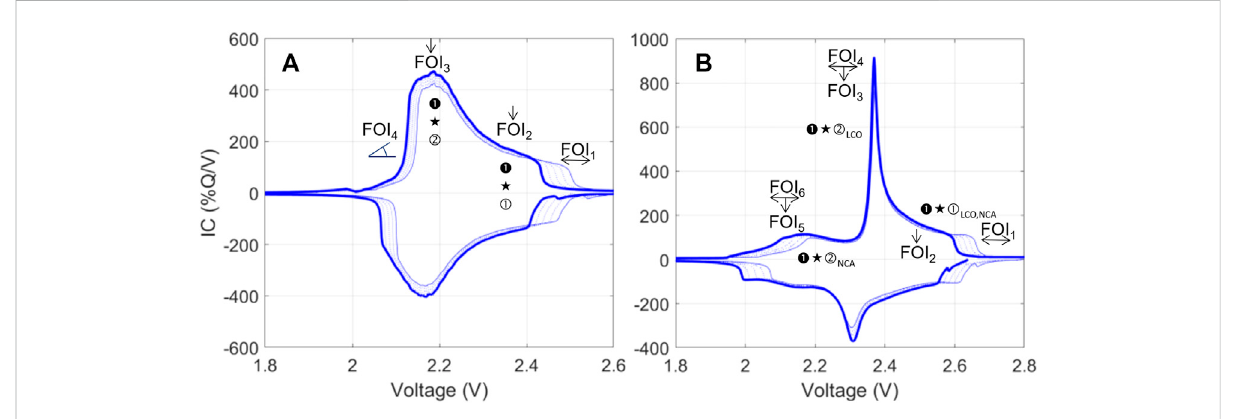
FIGURE 13 (A) Peakevolutionfromthepristinecell(thick line)to15%LLI,10%LAM PE ,and10%LAM NE (thinline)andintermediates(dottedlines)for (A)